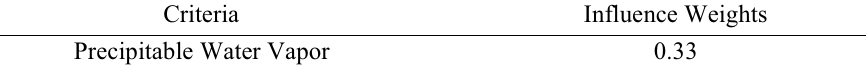
Table 3. Weight of influencing